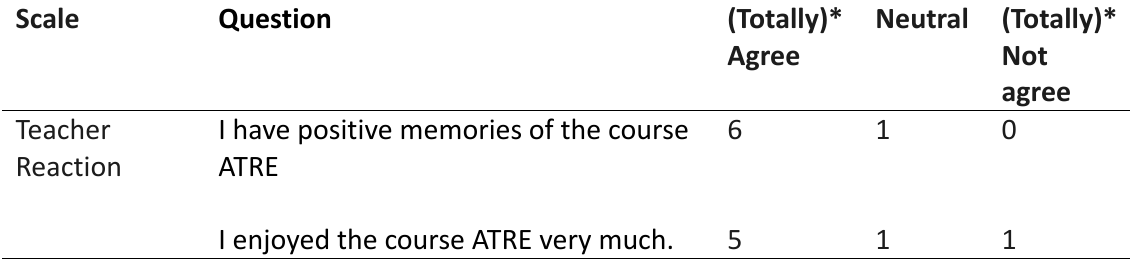
Table 3. Summary of respondents